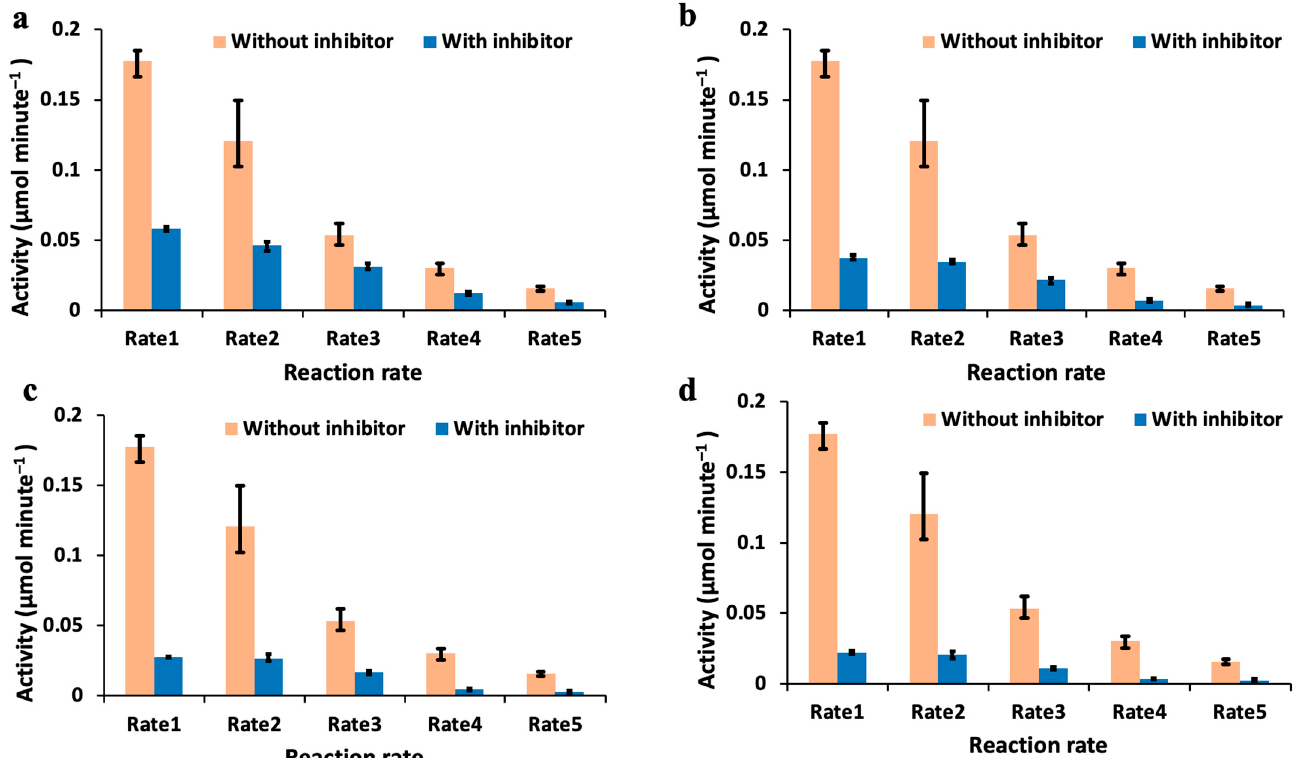
Figure 5. The activity calculated from the enzyme kinetics monitored over time by the 3D-printed spectrophotometer is shown here. This activity measured under the influence of different volume concentrations of the inhibitor is compared with the activity measured without any inhibitor at different reaction kinetics rates. ( a ) The activity for volume concentration A of the inhibitor is compared with the activity without any inhibition at different kinetics rates, including the error bars. ( b ) The activity for volume concentration B of the inhibitor used is compared with the activity without any inhibition at different kinetics rates. ( c ) The activity for volume concentration C of the inhibitor used is compared with the activity measured without any inhibition at different kinetics rates. ( d ) The activity for volume concentration D of the inhibitor used is compared with the activity measured without any inhibition at different kinetics rates.